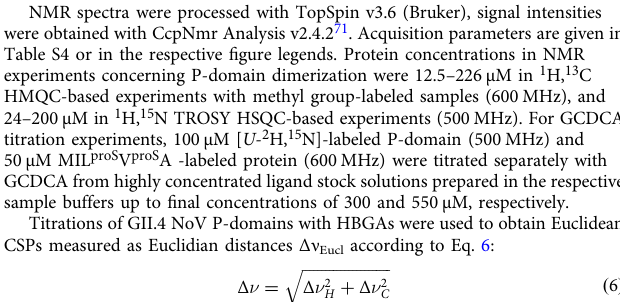
Table S4 or in the respective fi gure legends. Protein concentrations in NMR experiments concerning P-domain dimerization were 12.5 – 226 µM in 1 H, 13 C HMQC-based experiments with methyl group-labeled samples (600MHz), and 24 – 200 µM in 1 H, 15 N TROSY HSQC-based experiments (500MHz). For